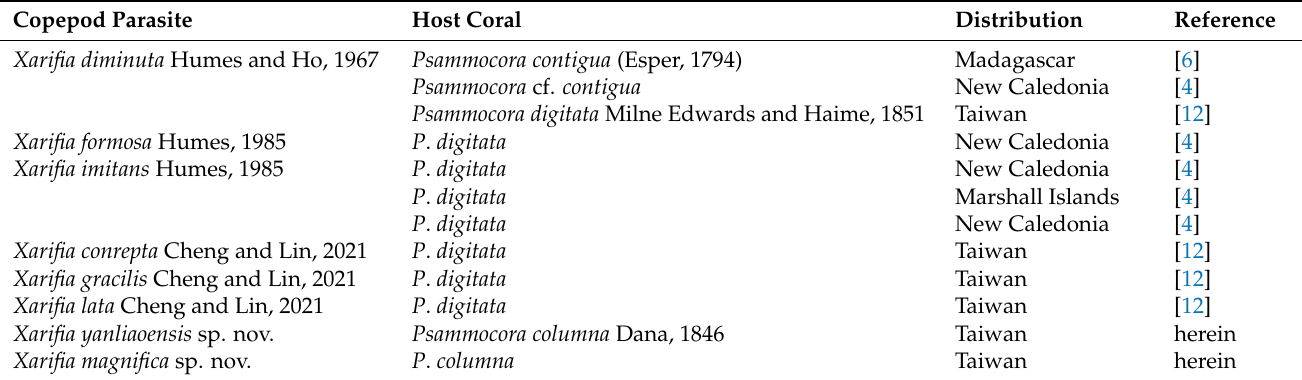
Table 1. Eight species of Xarifia copepods associated with Psammocora